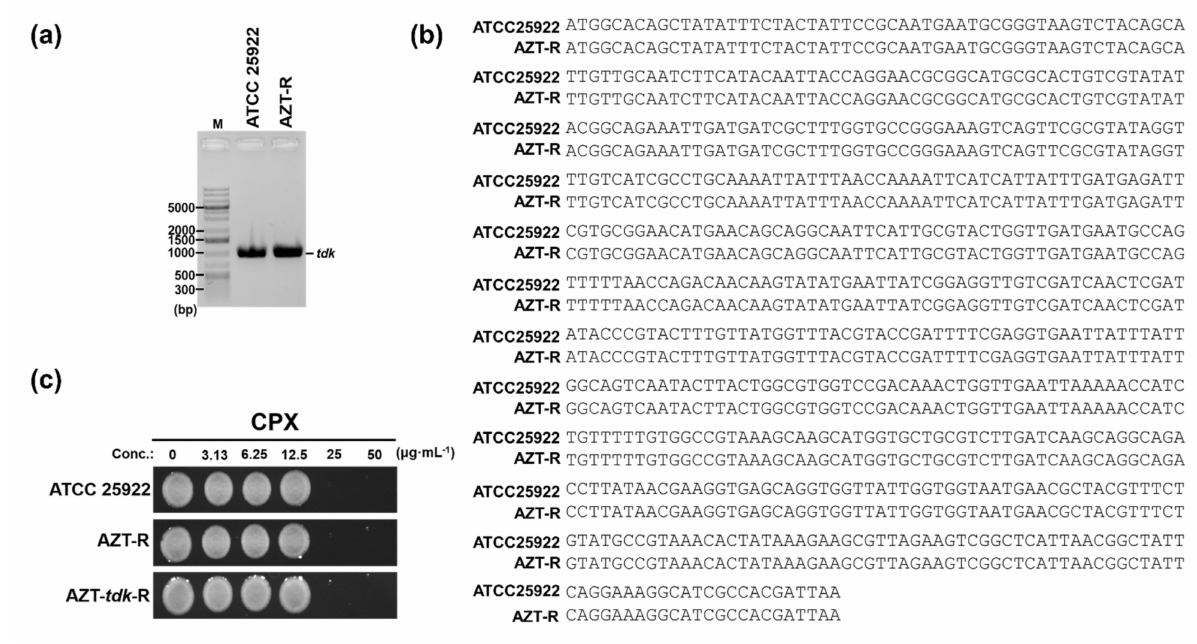
Figure 3. Bactericidal activity of CPX in AZT resistant strains. ( a ) PCR amplification of the tdk - encoding gene. Sequence information for ATCC 25922 was obtained from the NCBI database (accession No. CP009072.1). Sequence alignment of ( b ) the tdk gene. DNA sequencing results of tdk